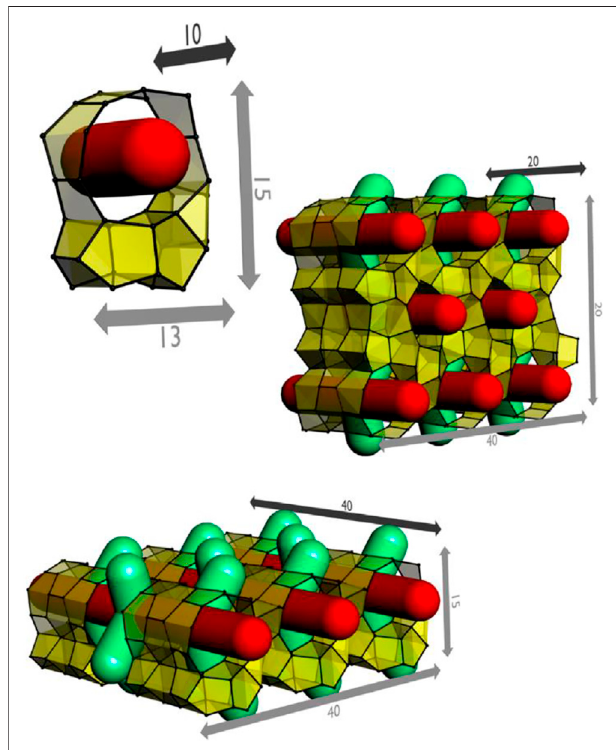
FIGURE 1 | Representation of idealized precursor and two nanoslabs (sizes indicated in Å units). Straight channels are indicated in red, zigzag channels in green (adapted with permission from Martens et al.,